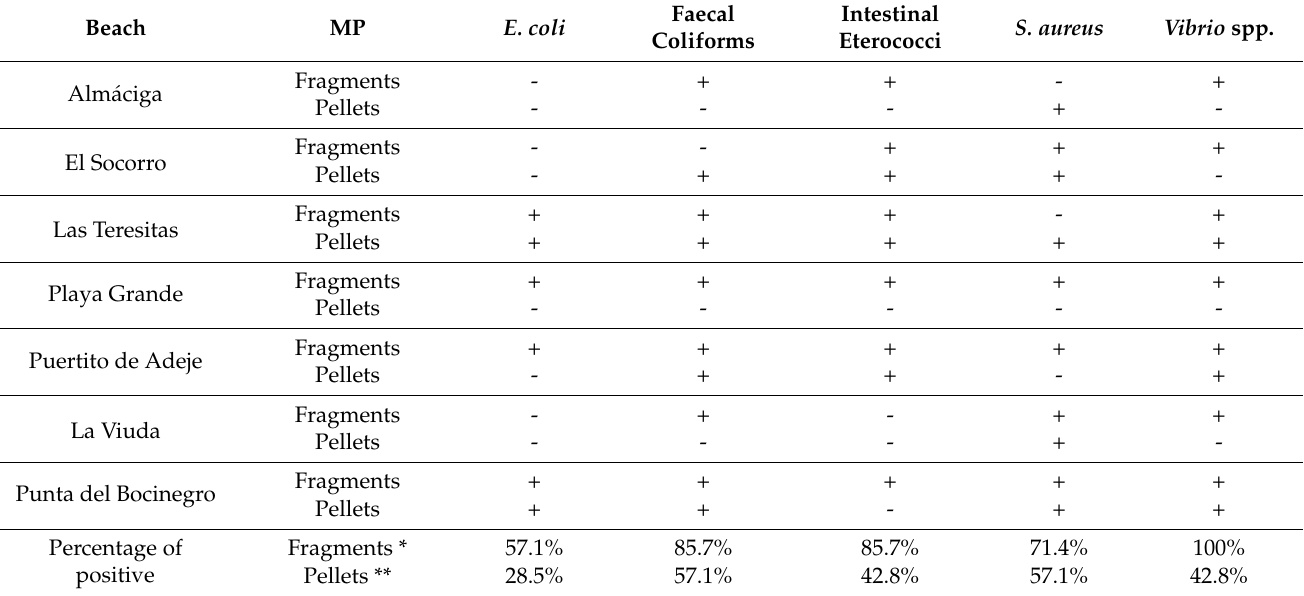
Table 2. Bacterial content of MPs collected from the seven beaches of the island of